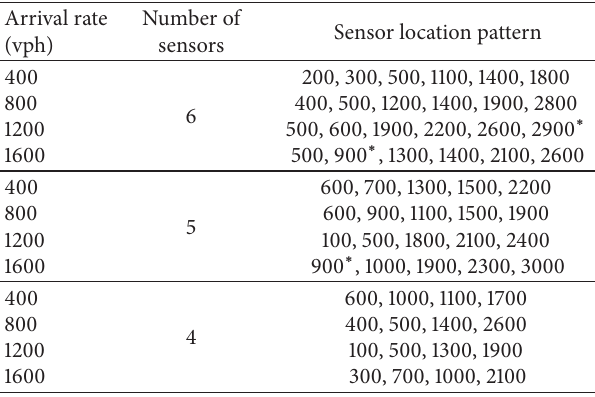
Figure 12: Comparison among MARE in different number of sensors for vehicle-actuated traffic signals.